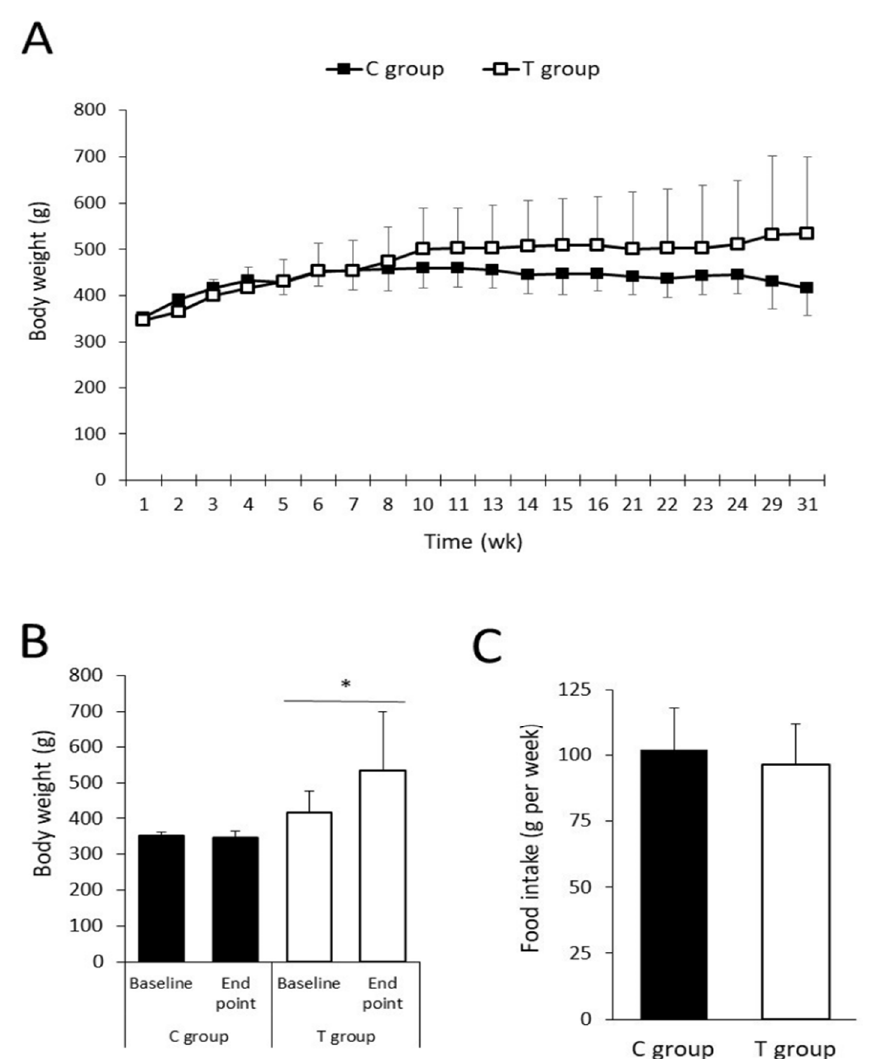
Figure 2. Body weight progression, body weight (BW) gain and average of hypercaloric diet (HD) food intake during the intervention. No statistically significant differences were observed in BW ( A ) between the experimental groups in spite of their divergent growing tendencies. BW gain ( B ) was statistically significant in T group (346.0 ± 18.4 versus 533.5 ± 165.8 g at baseline and at the end point, respectively; p = 0.031) but no statistical significant differences were found in C group (352.3 ± 9.9 versus 416.8 ± 60.3 g at baseline and at the end point, respectively; p = 0.625). The FFP administration did not alter HD food intake ( C ), which was comparable in both groups (101.9 ± 16.2 versus 96.5 ± 15.7 g in C and T groups, respectively; p = 0.413). Values are expressed as mean ± SD. * p < 0.05.